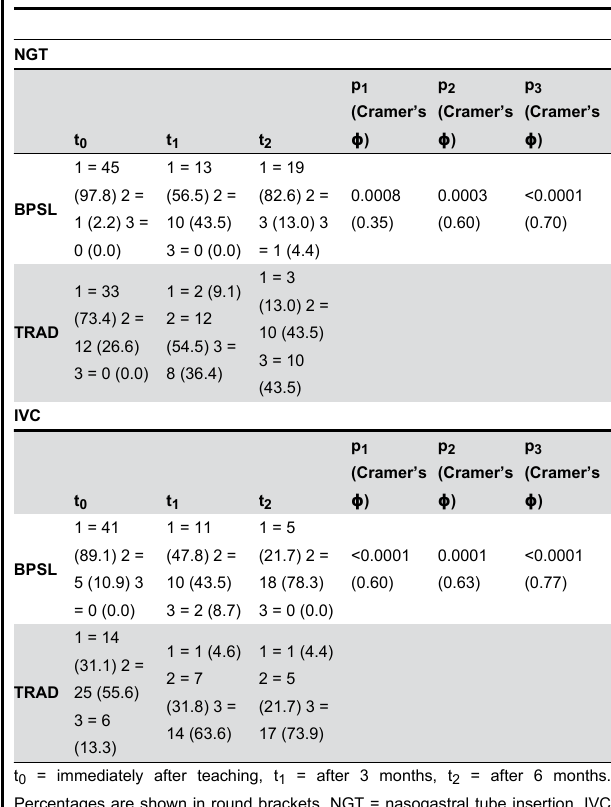
Table 3. Global rating categorised into 1 = “competent students”, 2 = “borderline students” and 3 = “incompetent